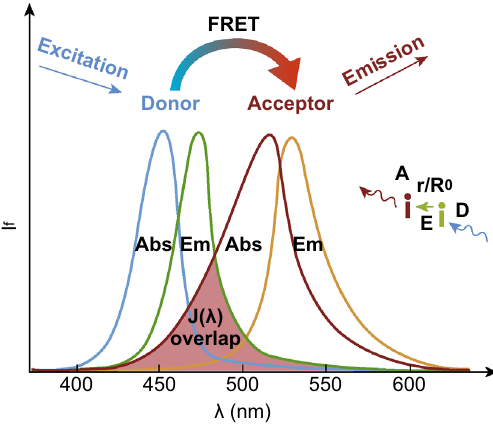
Fig. 13 Basic principles of the FRET process. A donor fluorophore (D) is excited and the energy is transferred in a distance and orientation-dependent manner ( r / R o ) to an acceptor molecule (A). The energy transfer occurs through non-radiative dipole–dipole coupling (E). The acceptor, if a fluorescent molecule, will emit fluorescence but at a lower energy and longer wavelength [267]. Copyright (cid:2) 2017 Elsevier